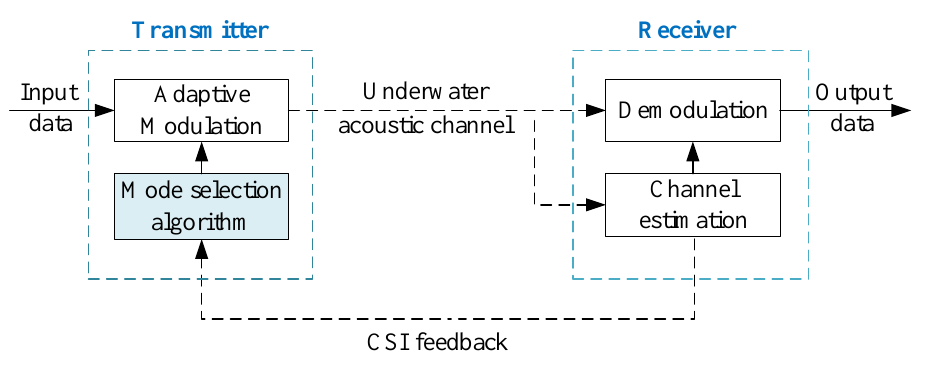
Figure 1. A system model of UWA